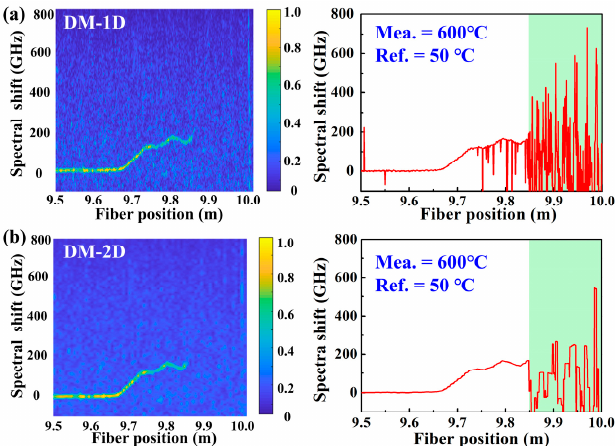
Figure 3. Temperature distribution demodulated by using the DM combined with 1D and 2D meth- ods, i.e., ( a ) DM-1D, ( b ) DM-2D, respectively, at the temperature of 600 °C. The FUT between 9.85 was 92.2 GHz, i.e., ∆ fn’ = 92.2 GHz. This indicated that the temperature distribution at the and 10.0 m was placed in the furnace, represented by the cyan box. Note that in the DM, the Ref. temperature of 600 ◦ C could be accurately recovered by using SM-2D. signal and Mea. signal were defined as signals acquired at the temperature of 50 °C and 600 °C, respectively.